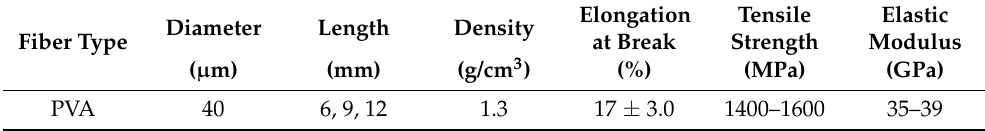
Figure 1. Particle size distribution curve. Table 1. The mechanical properties of the PVA fibers. (Data come from